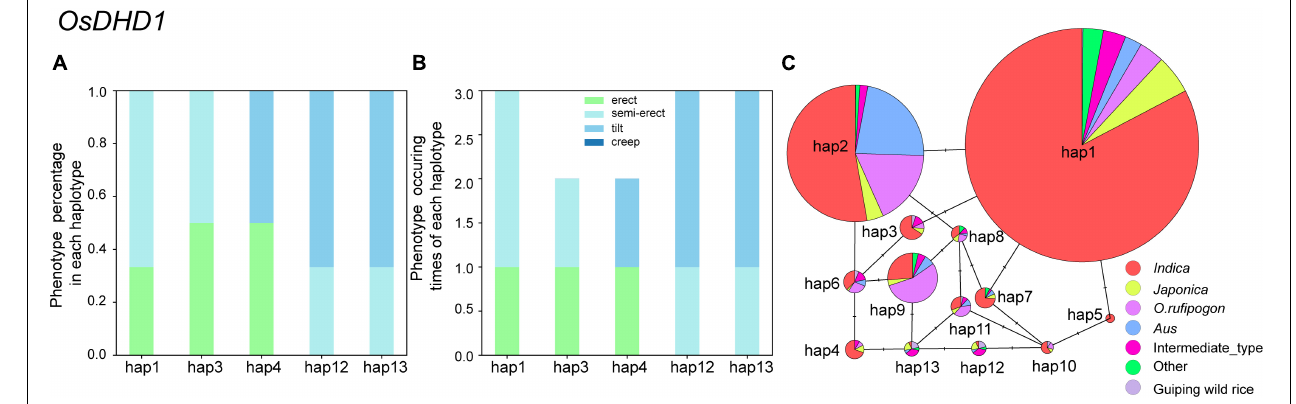
FIGURE 4 | Analysis of the haplotype networks of OsDHD1 in the Guiping wild rice population and the 5K dataset. (A,B) Phenotypic analysis according to the OsDHD1 haplotype. (C) Haplotype networks of OsDHD1 . The circle size is proportional to the sample quantity within a given haplotype. The short solid lines represent genetic distances between